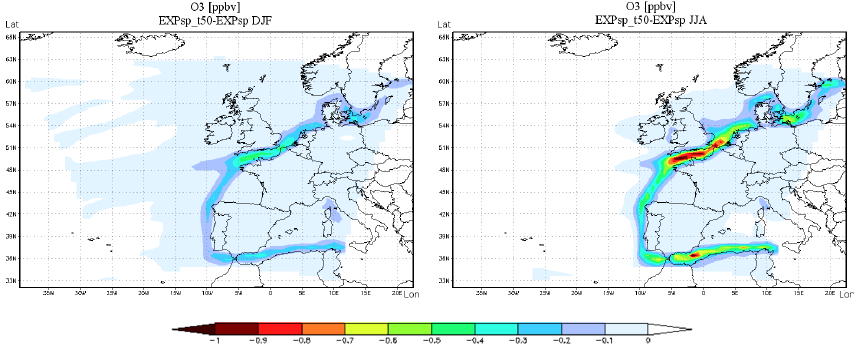
Fig. 12. Sensitivity test on τ , the dilution time: surface O 3 difference between runs EXPsp t50 and EXPsp for winter (left) and summer (right)